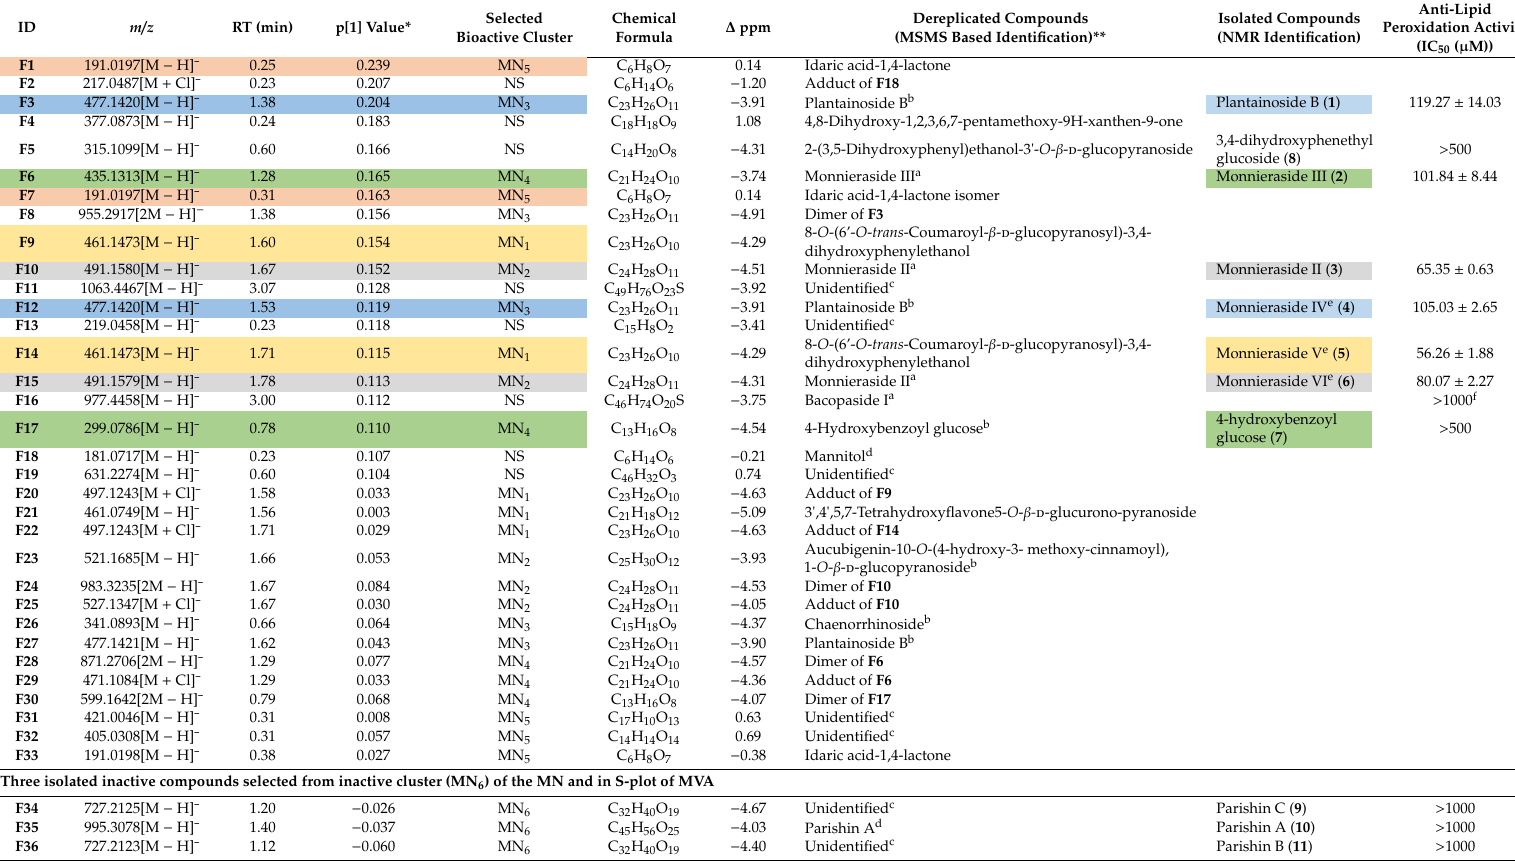
Table 1. The nineteen bioactive candidate features ( F1 – F19 ) ranked by p[1] value from S-plot of MVA and twenty-five bioactive candidates selected from prioritized clusters of MN (MN 1 –MN 5 ). Ten potential bioactive compounds prioritized from the merging of MVA and MN approach are highlighted (one color per cluster). IC 50 values of the compounds on anti-lipid peroxidation activity are expressed in µ M and as an average from triplicate experiments ± standard